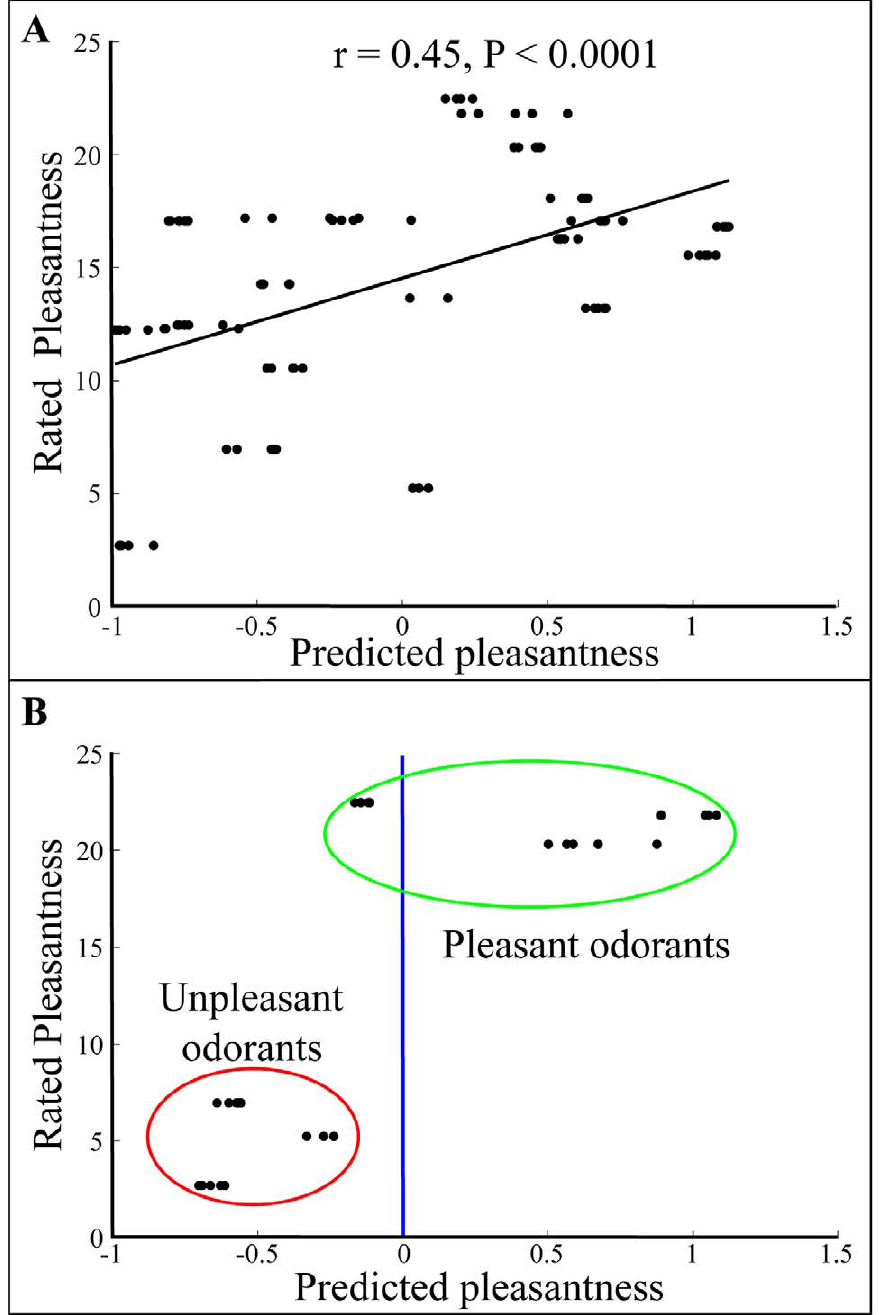
Figure 3. Predicting pleasantness of novel odorants: Neat odorants. A. The correlation between the eNose pleasantness prediction values of 21 odorants and the values obtained from human participants. Each dot represents an eNose measurement (many dots overlay) B. The result of the classification algorithm when removing all odorants with medium pleasantness ratings (below and above 1/3 and 2/3 of the pleasantness scale respectively).